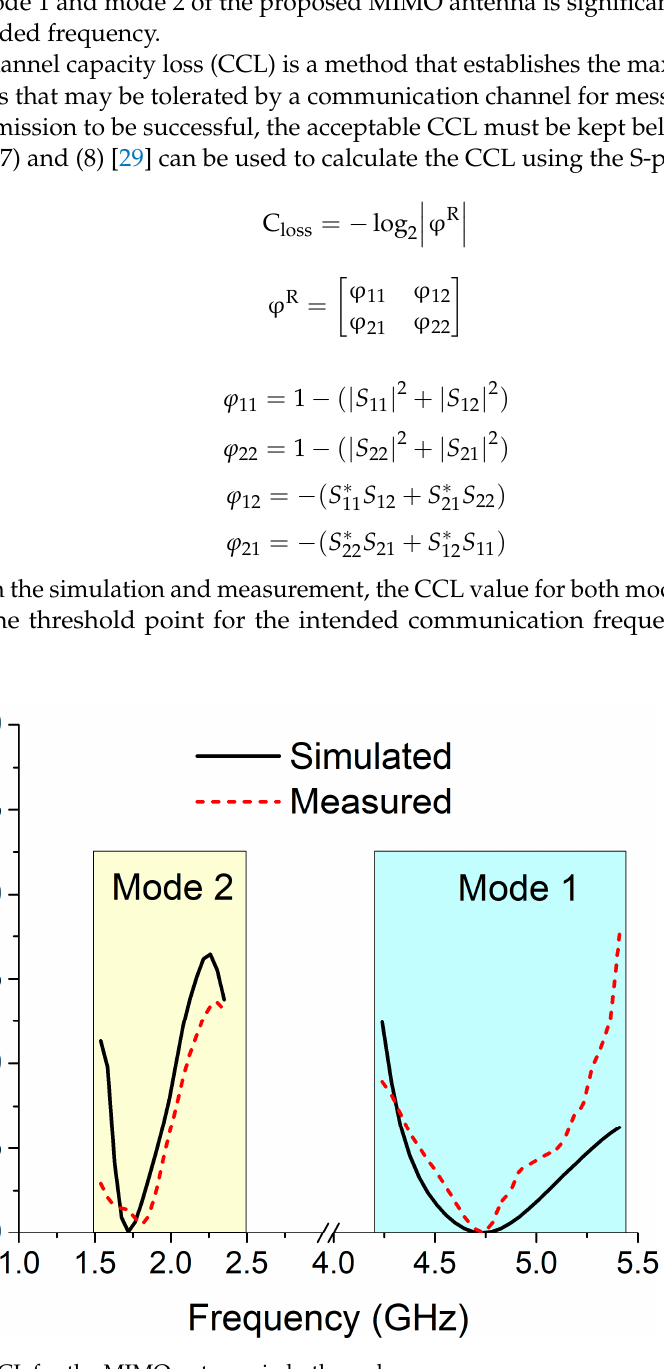
Figure 34. CCL for the MIMO antenna in both modes.